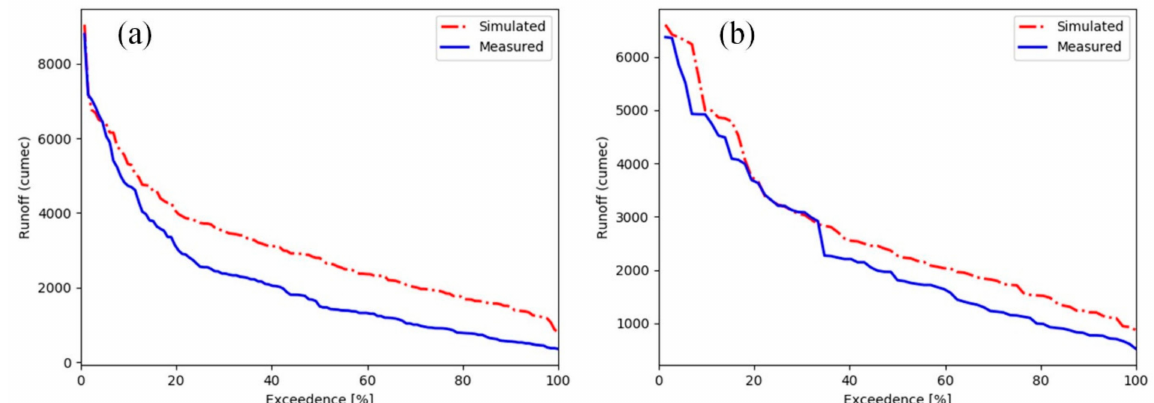
Figure 6. Comparison of flow duration curves of simulated runoff using the SWAT model against observed runoff at Waizhou station: ( a ) calibration; ( b ) validation.